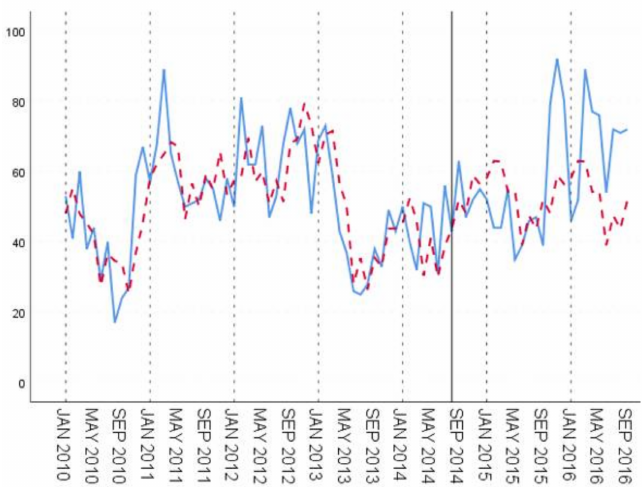
Figure 13. Fitting and prediction results for the time series model, group 2.